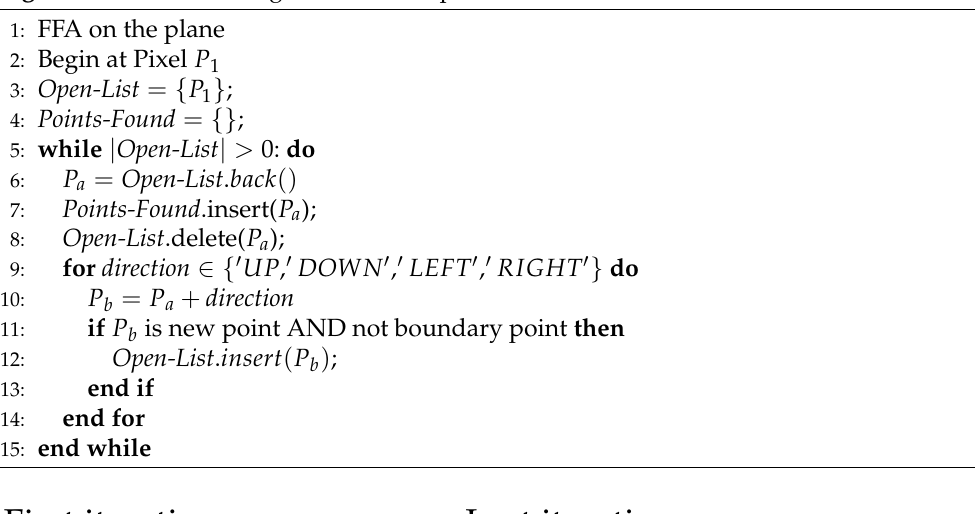
Algorithm 1 Flood Fill algorithm on the plane.